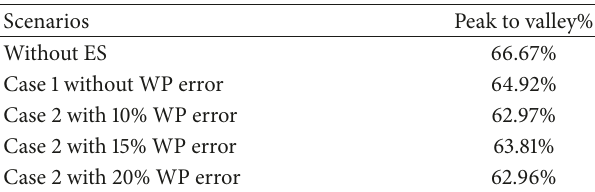
Table 5: Peak to valley in different